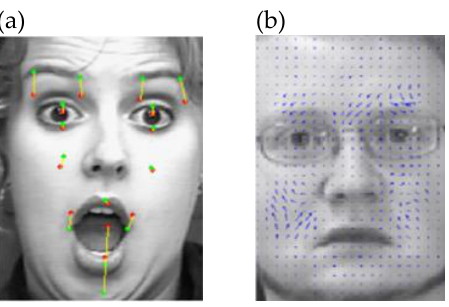
Figure 7. Facial expression recognition: ( a ) feature point tracking; ( b ) dense flow tracking [317]. A group of participants were tested to record the facial EMG (fEMG) activity. Fol-